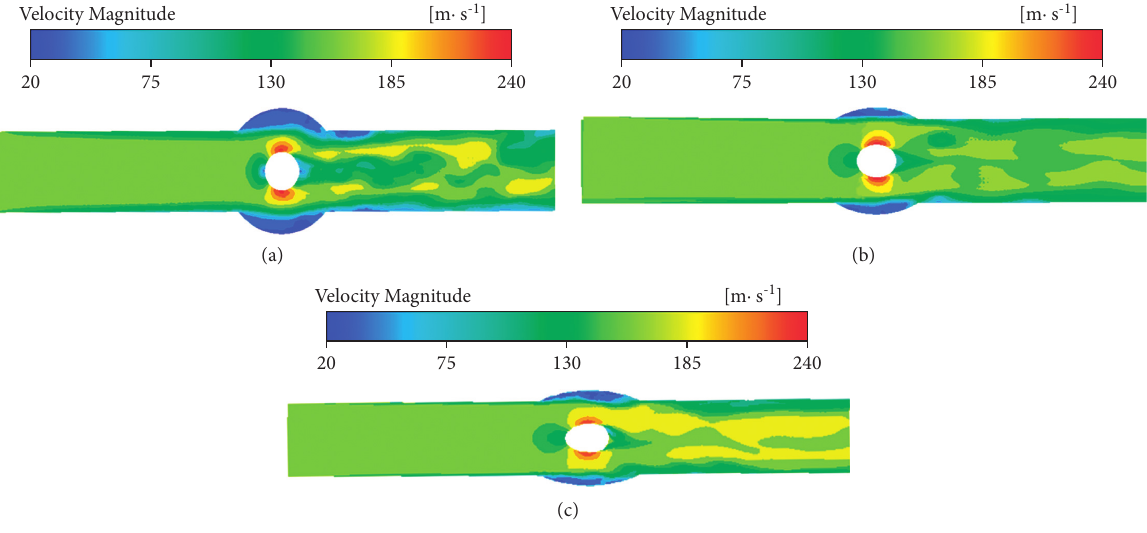
Figure 13: Velocity contours. (a) 90 ° installation angular velocity cloud chart. (b) 60 ° installation angular velocity cloud chart. (c) 45 ° installation angular velocity cloud